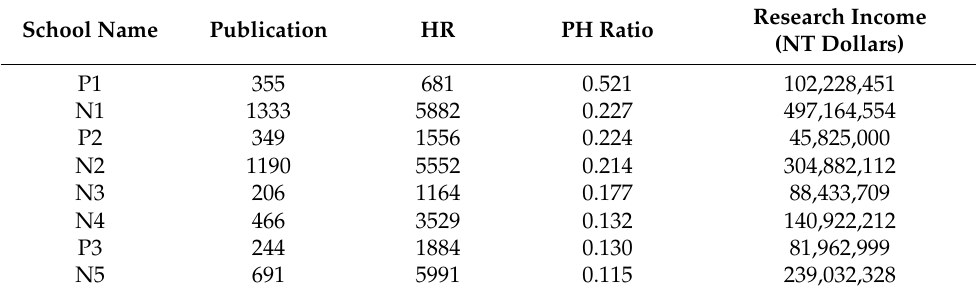
Table 3. PH Ratio in